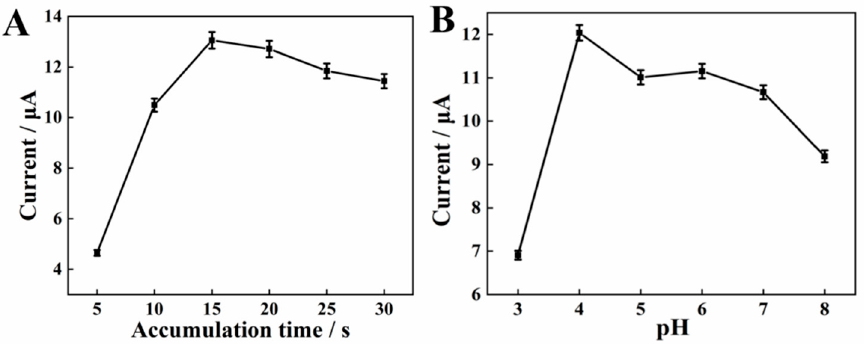
Figure 4. Effects of accumulation time ( A ), activation pH value ( B ) on the anodic peak currents of 10 µ M SY.